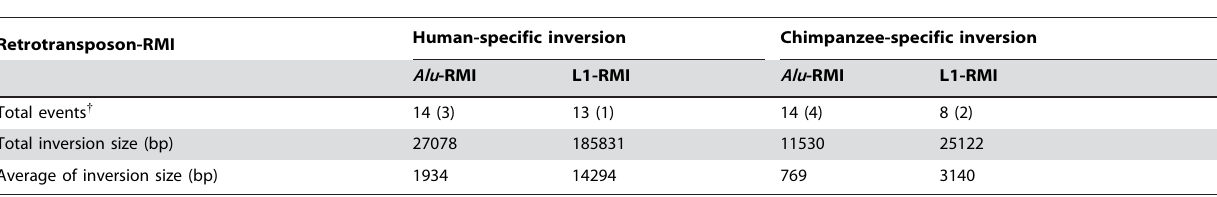
Table 1. Summary of retrotransposon recombination-mediated inversion.